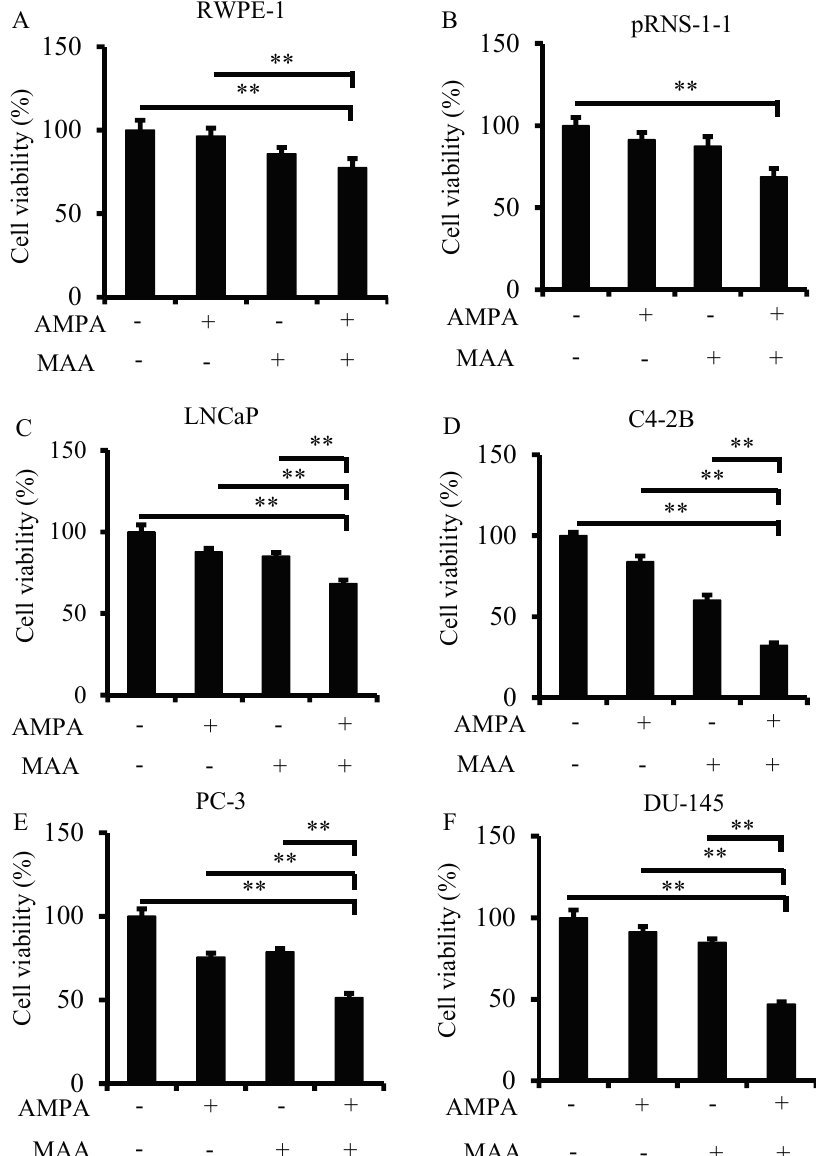
Figure 1. The combination of aminomethylphosphonic acid (AMPA) and methoxyacetic acid (MAA) suppresses cancer cell viability. ( A – F ) Normal prostate epithelial cells and prostate cancer cells were plated in 96-well plates in triplicate per group and then treated with 15 mM AMPA, 5 mM MAA and a combination of both for 72 h. The viable cells were measured using the CellTiter-Glo ® Luminescent Cell Viability Assay. The data are presented as the mean ± standard error of the mean (SEM) of three independent experiments ( n = 3). ** p <